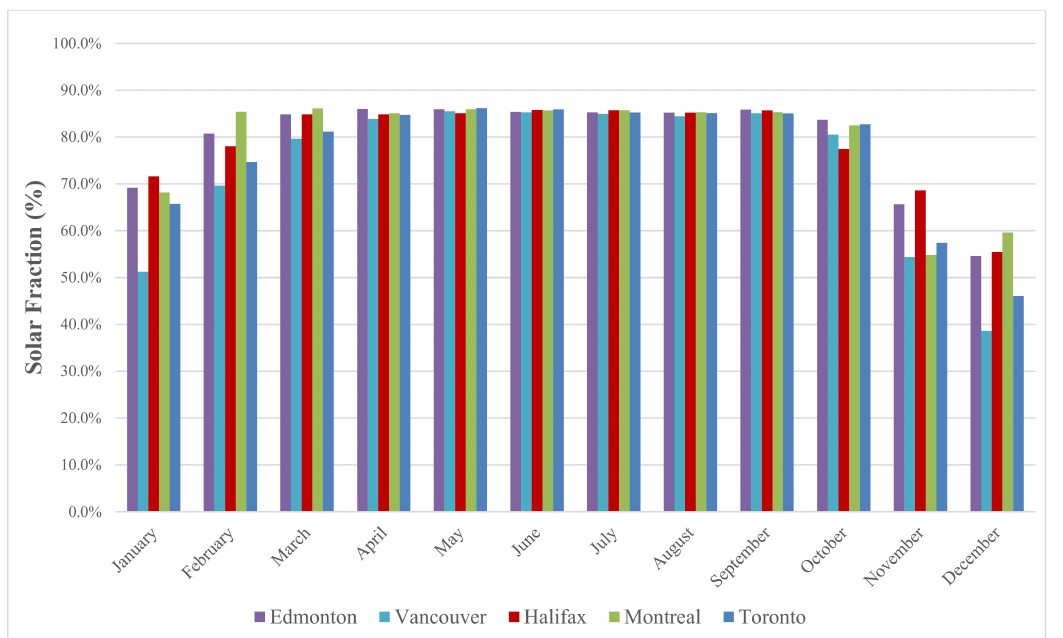
Figure 20. Monthly SF of MCPVT-HP system in different